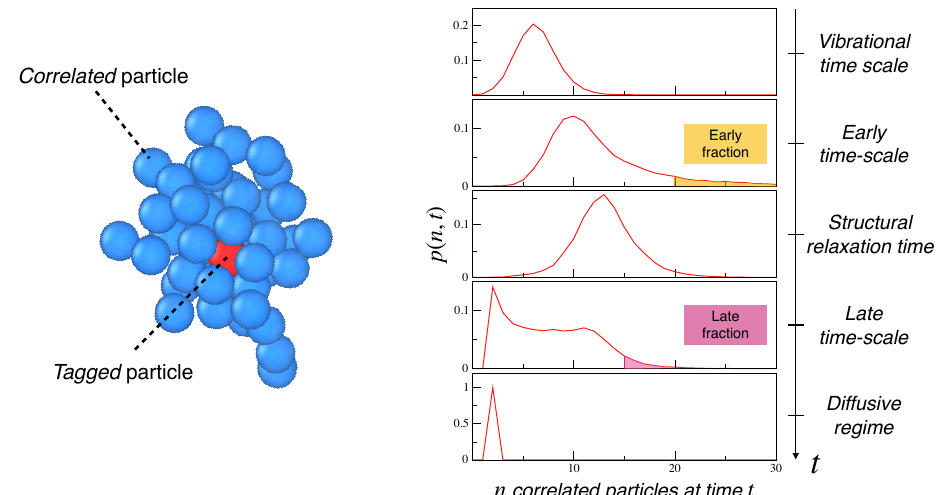
Figure 3. ( Left ) Snapshot of the (blue-colored) particles being MI-correlated to a (red-colored) tagged one. ( Right ) Time evolution of the distribution of the (red) particles correlated to n other (blue) particles at time t , p ( n , t ) , for a state of the C set (same shape for both states). Moving from short to long times, i.e., from the top to the bottom of the stacked plots, the second and the fourth plot correspond to t = τ early and t = τ late , respectively, when the standard deviation σ ( t ) of p ( n , t ) is at a local maximum (see Figure 4(right)). The fractions of particles with higher correlation at these two times are highlighted. They are referred to as early and late fractions [18]. Their exact definition is given in main text. The data were taken from Reference [23].